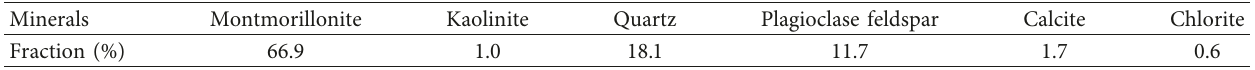
Table 2: The mineral fraction of CB based on X-ray diffraction analyses.